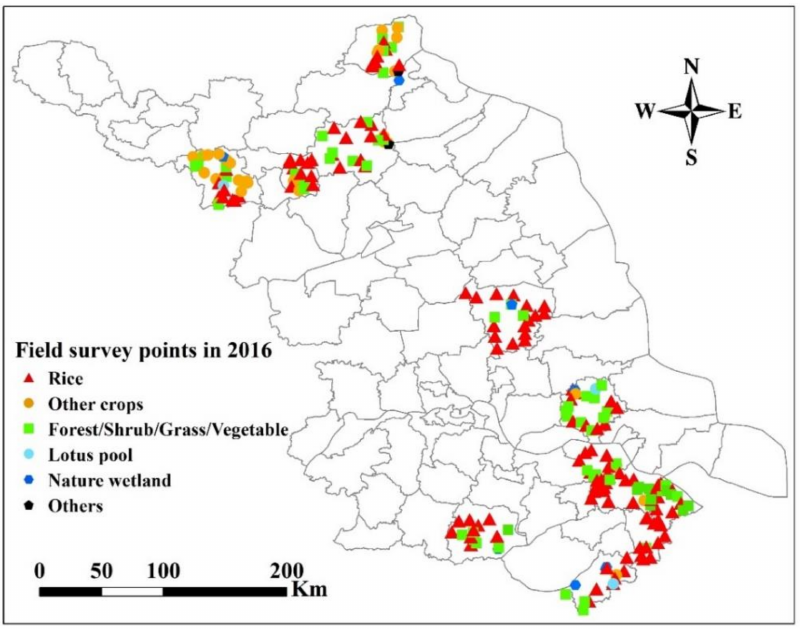
Figure 4. Spatial distribution of field survey points in 2016 across Jiangsu